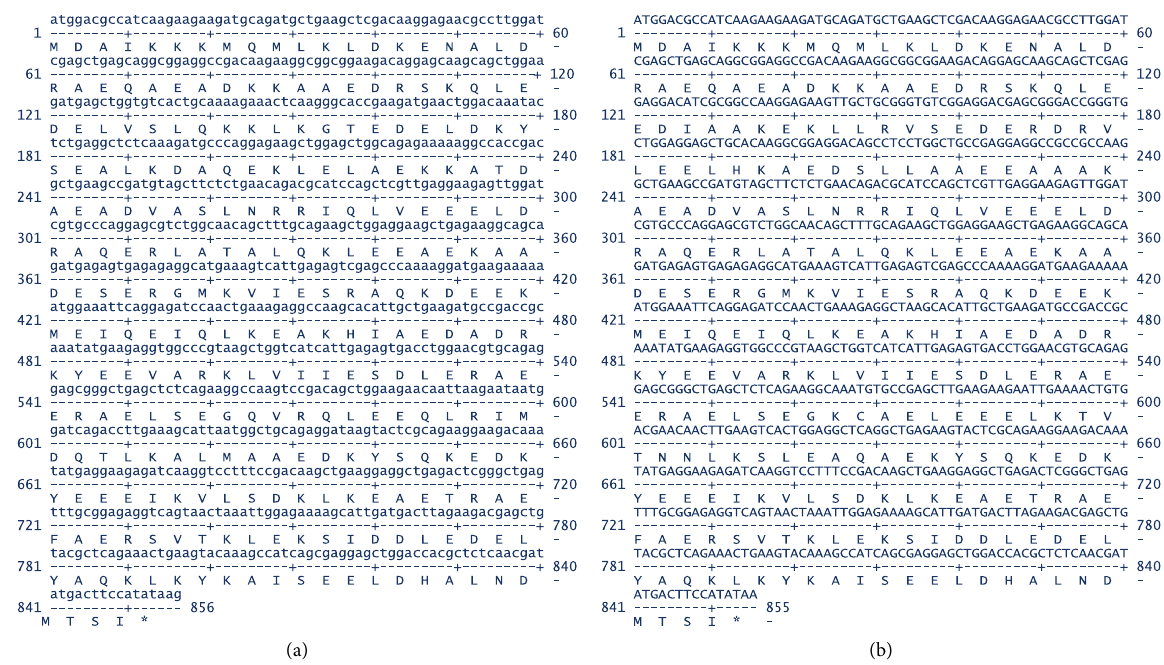
Figure 1: Te nucleotide sequence and derived amino acid sequence of cDNA coding for Cyn heart (a) TPM1 α and (b) TPM1 κ .